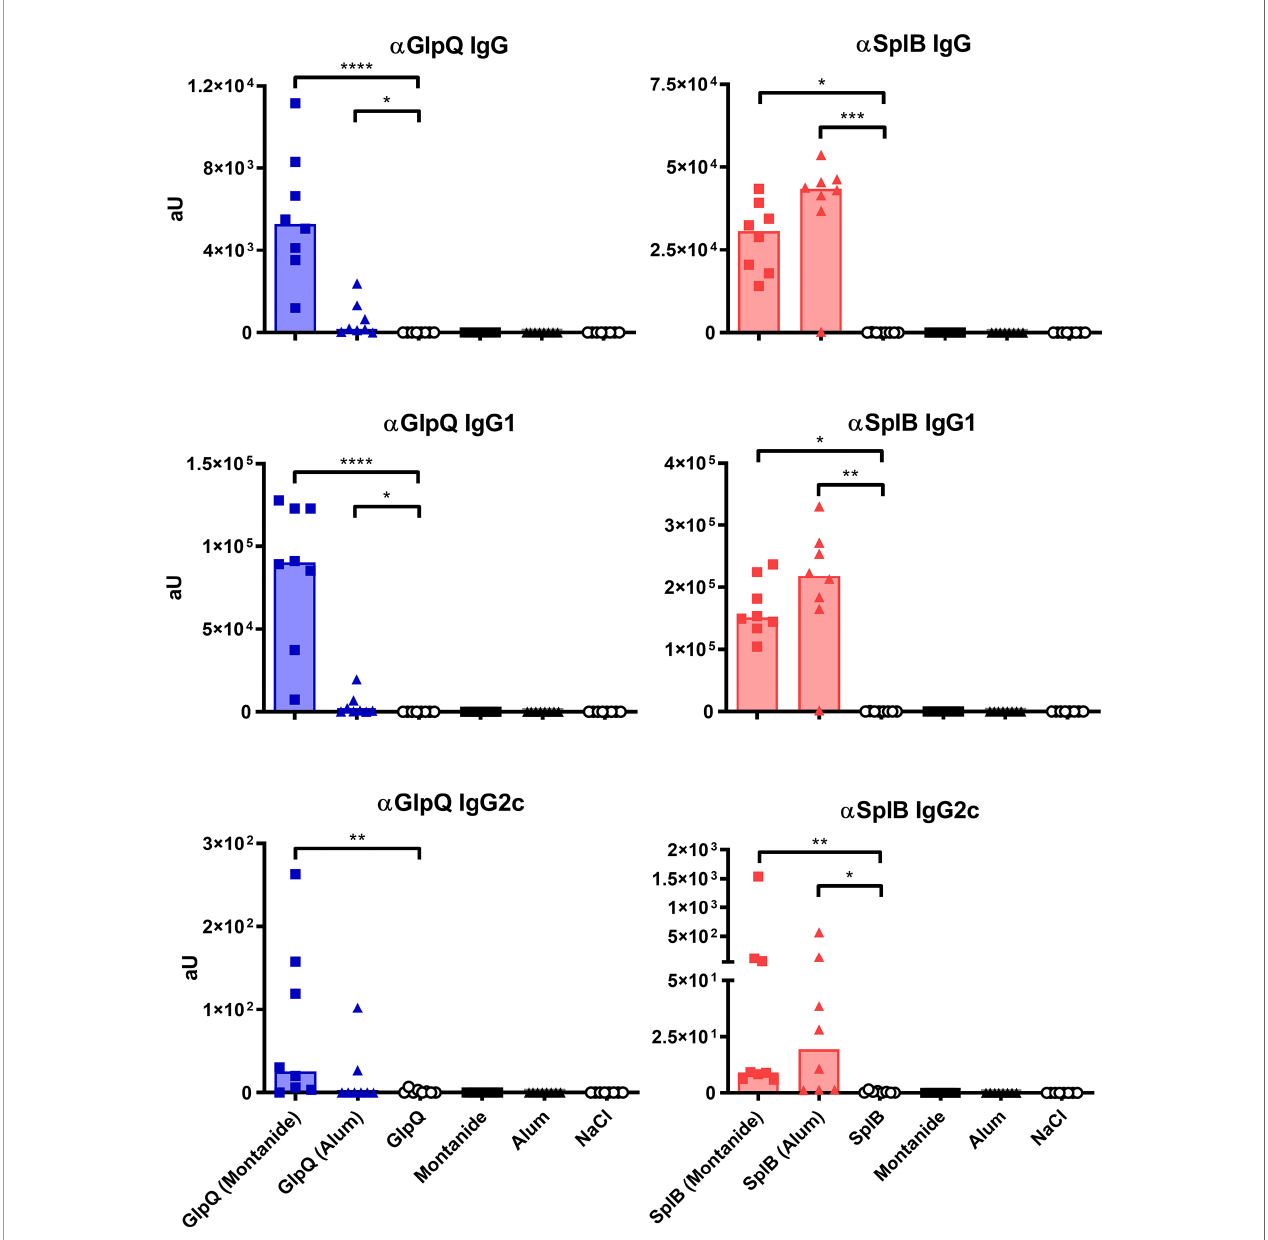
FIGURE 8 | Alum and Montanide affected antigen-speci fi c IgG production differently. Antigen-speci fi c IgG, IgG1 and IgG2c were measured in the serum 7 days after boost via ELISA. Data are presented as median. n = 8 animals per group. *p < 0.05; **p < 0.01; ***p < 0.001; ****p < 0.0001. Group comparisons that are de fi ned in the “ Statistical analysis ” section but not shown here are not signi fi